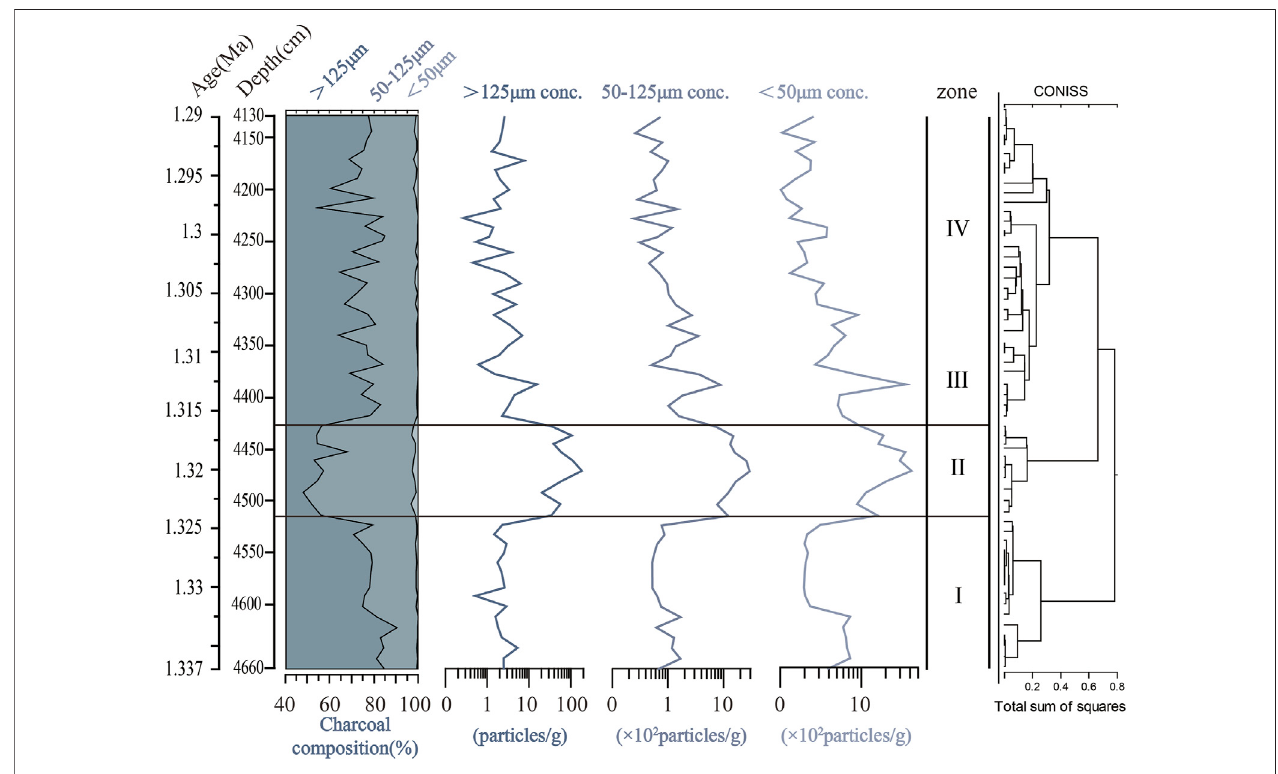
FIGURE 6 | Pro fi les of the content and concentrations of coarse ( > 125 µm), medium (50 – 125 µm) and fi ne ( < 50 µm) charcoal particles for the Banshan site. CONISS results are shown on the far right.